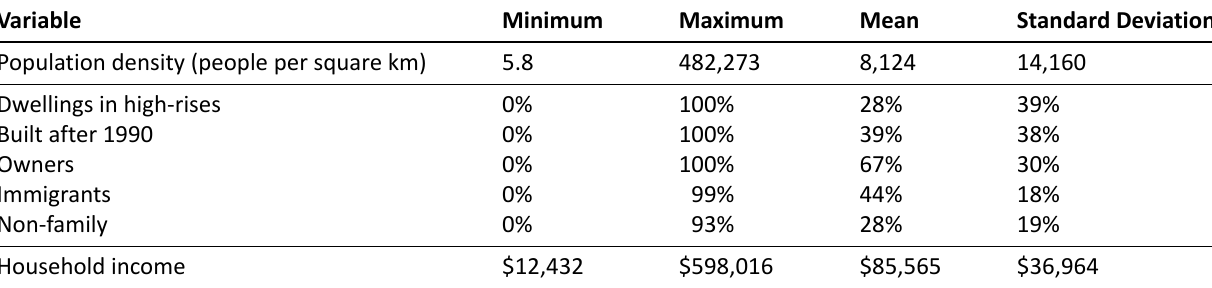
Table 3. Variable summary for DAs in suburban municipalities. Source: authors’ calculations using 2016 Statistics Canada DA